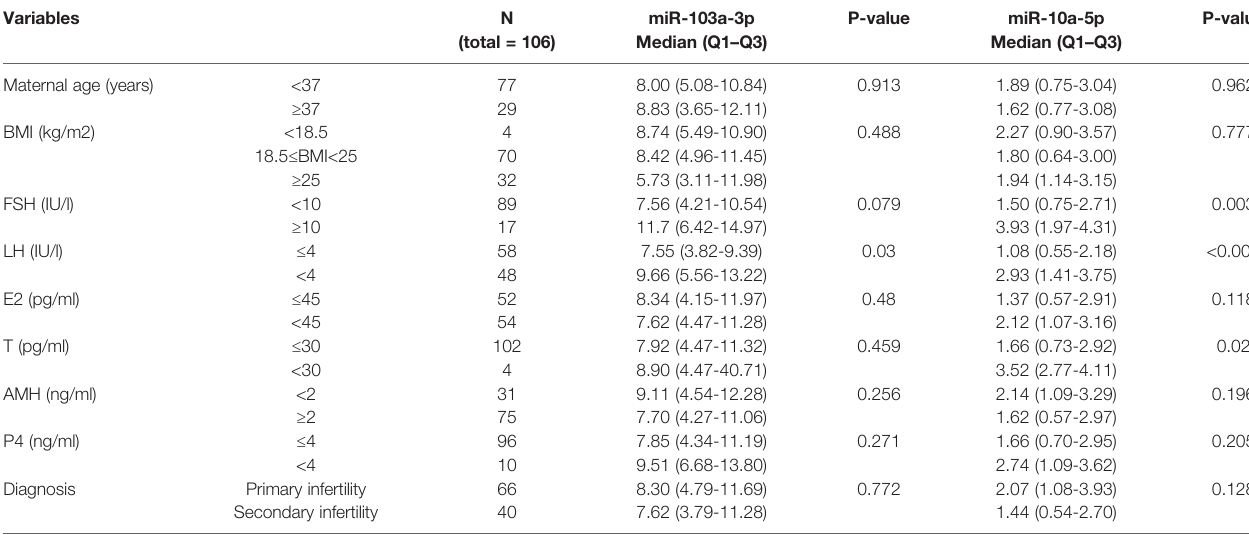
TABLE 1 | Correlation between miR-103a-3p or miR-10a-5p expression and Clinical and biochemical characteristics of patient with IVF-ET treatment. Variables